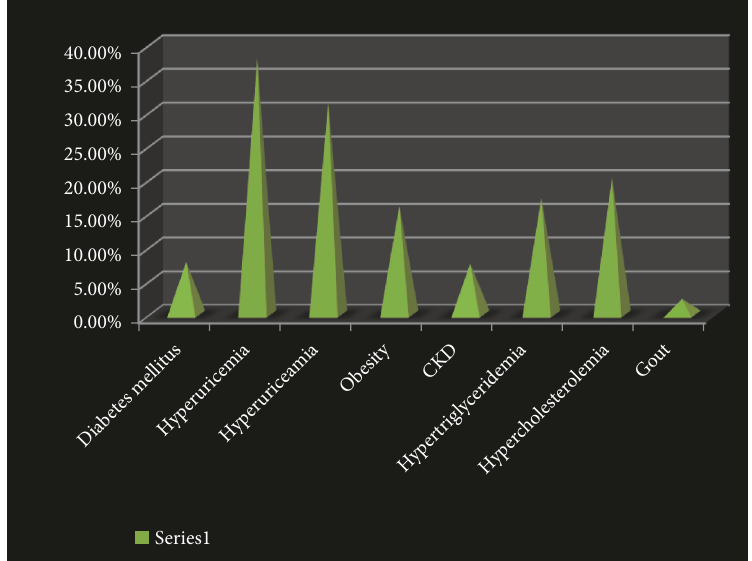
Figure 1: Prevalence of some medical condition in the community.